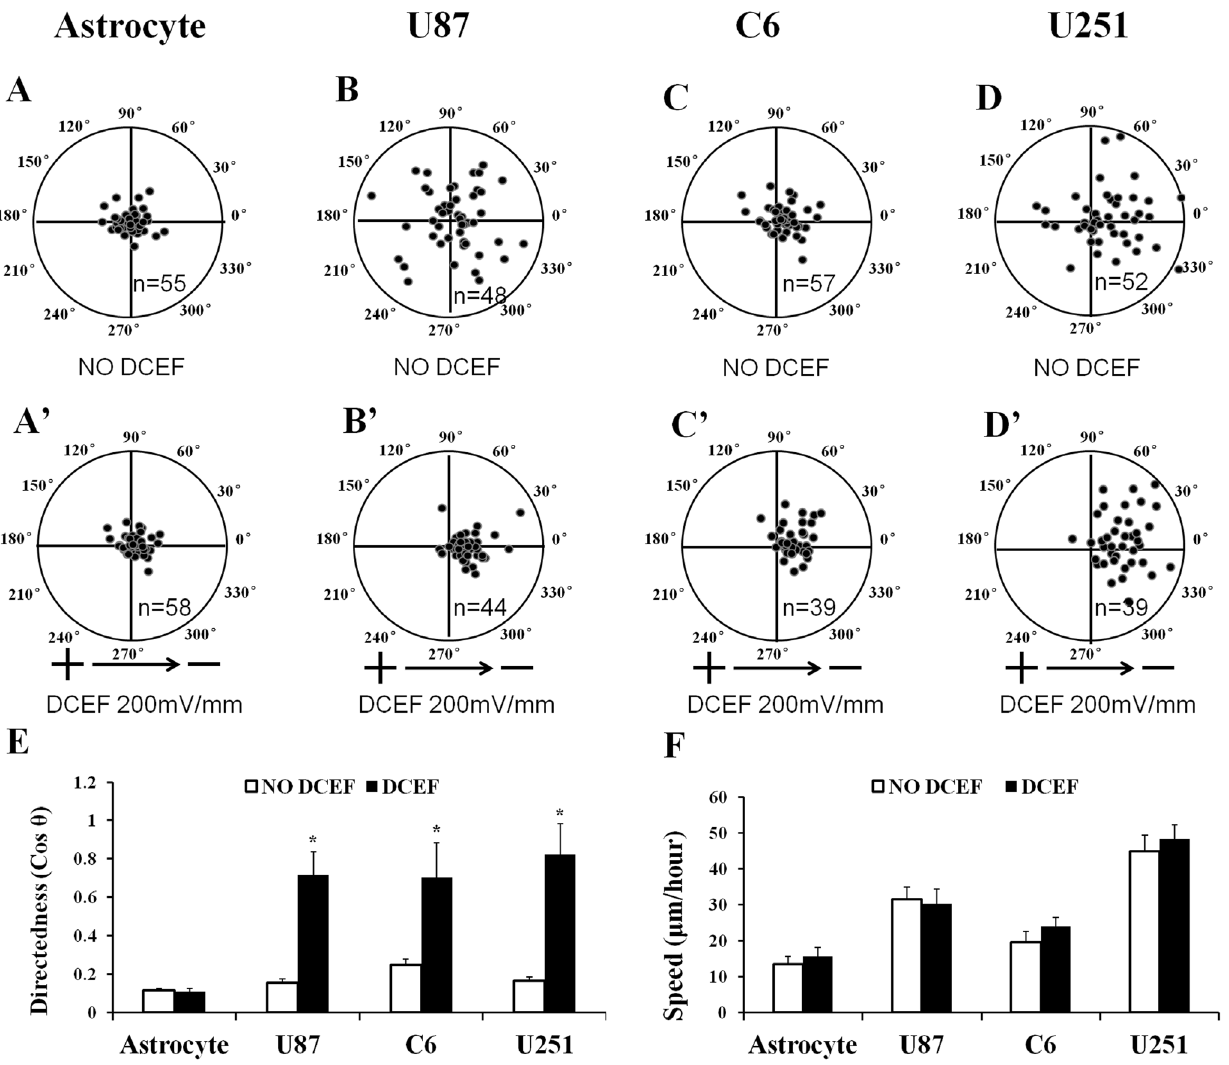
Figure 1. DCEF-mediated induction of directional migration of glioma cells. In the absence of DCEF, Astrocytes (A), U87 glioma cells (B), C6 glioma cells (C) and U251 glioma cells (D) migrated with equal probability in all directions. The DCEF in a 200 mV/mm could not direct the migration of the astrocyte (A 9 ). Glioma cells migrated toward the cathode in a 200 mV/mm DCEF after two hours of exposure (B 9 –D 9 ). An analysis of direction (cos h ) and speed ( m m/h) of glioma cells migration (E and F). * P ,